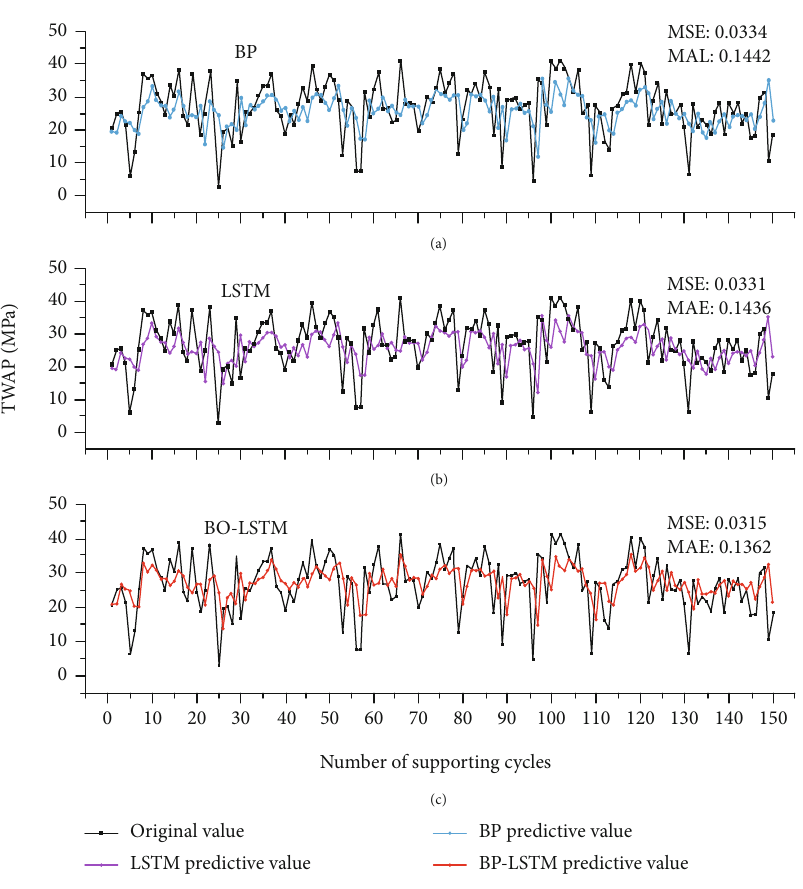
Figure 12: Comparison among the TWAP prediction performances of three models for 80# shield.